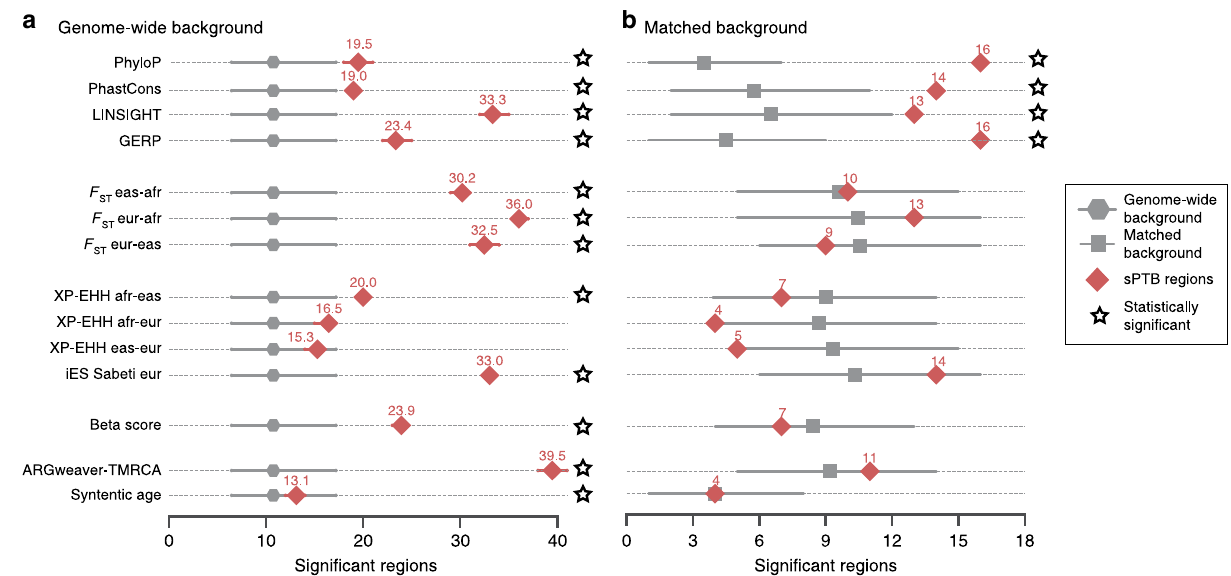
Fig. 5 sPTB is enriched for evolutionary measures even after accounting for MAF and LD. a sPTB regions (red) are enriched for signi fi cant evidence of nearly all evolutionary measures (black stars) compared to the expectation from the genome-wide background (gray). For each evolutionary measure ( y - axis), we evaluated the number of sPTB regions with statistically signi fi cant values ( p < 0.05) compared to the genome-wide distribution of the metric based on 5000 randomly selected regions over 1000 iterations. The mean number of signi fi cant regions ( x -axis) is denoted by the red diamond with the 5th and 95th percentiles fl anking. The expected number of signi fi cant regions by chance was computed from the binomial distribution (gray hexagons with 95% con fi dence intervals). b Accounting for MAF and LD revealed enrichment for evolutionary measures of sequence conservation (PhyloP, PhastCons, LINSIGHT, GERP) among the sPTB-associated genomic regions. In contrast to a , the number of signi fi cant regions (among the 215 sPTB-associated regions) was determined based on 5000 MAF- and LD-matched sets. Similarly, the expected distribution (gray boxes) was determined using 1000 randomly selected region sets of the same size as the sPTB regions with matching MAF and LD